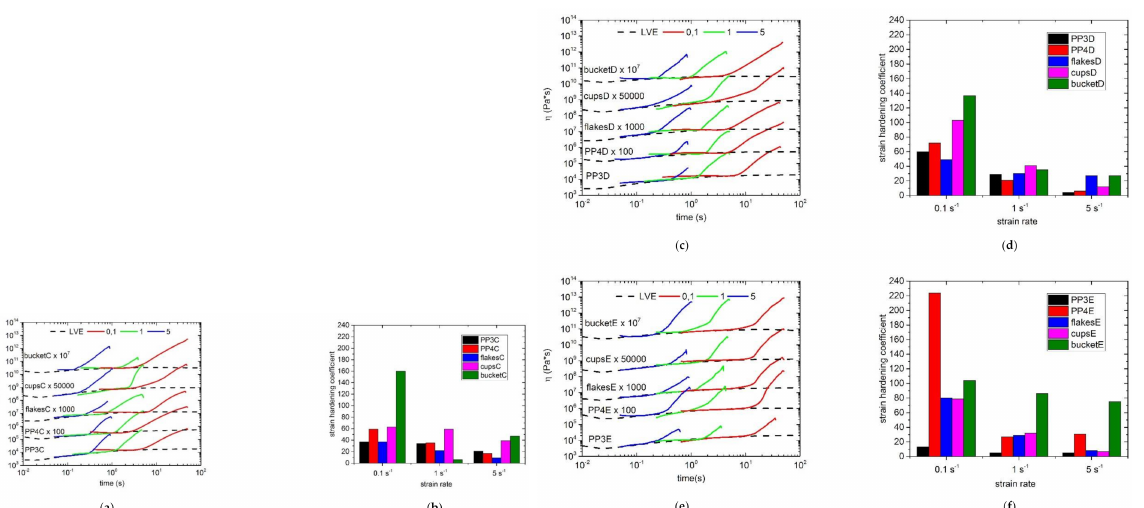
Figure 7. Extensional rheology curves of all samples with the blend series of long-chain branched polypropylene (LCB-PP) dimyristyl peroxydicarbonate (PODIC C 126) ( a ), with LCB-PP dilauroyl peroxide (PEROXAN LP) ( c ) and HMS-PP ( e ); Strain Hardening Coefficient of all samples with the blend series of LCB-PP PODIC C 126 ( b ), with LCB-PP PEROXAN LP ( d ) and HMS-PP ( f